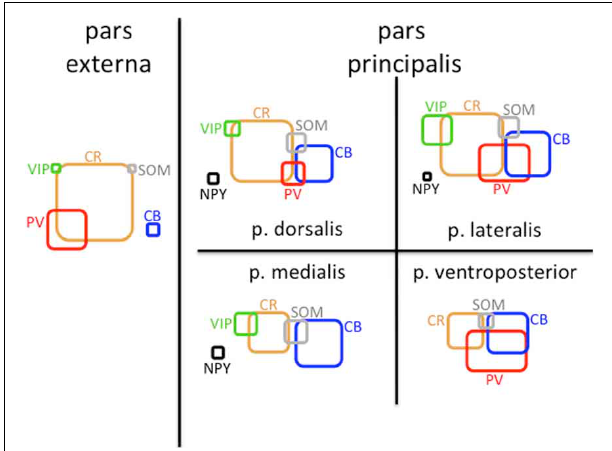
FIGURE 5 | Schematic of molecular marker expression is variable by subregion of the AON. Rounded rectangles are scaled so their areas represent the density of cells (mm 3 ) that are positive for the indicated molecular marker in that region. The amount of overlap represents the approximate fraction of cells that were double-labeled for the indicated